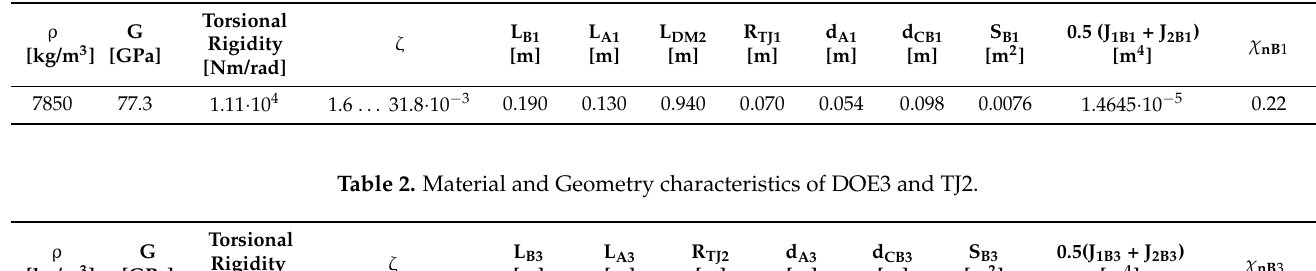
Table 1. Material and Geometry characteristics of DIE1 and TJ1.